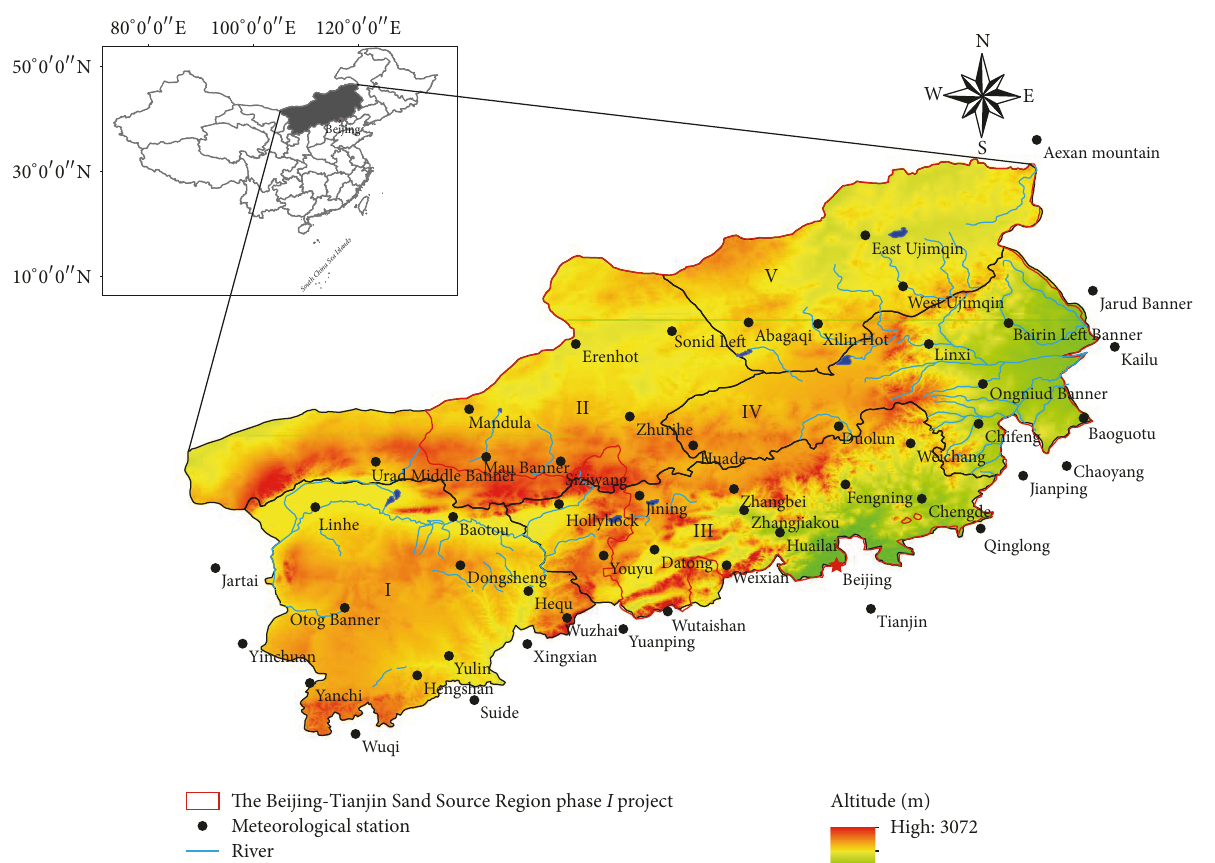
Figure 1: Location of the study area and meteorological stations. Greek capital numbers indicate the subregion division: I is the southwest subregion (SR-I), II is the northwest subregion (SR-II), III is the south-central subregion (SR-III), IV is the east-central subregion (SR-IV), and V is the northeast subregion (SR-V). Source: